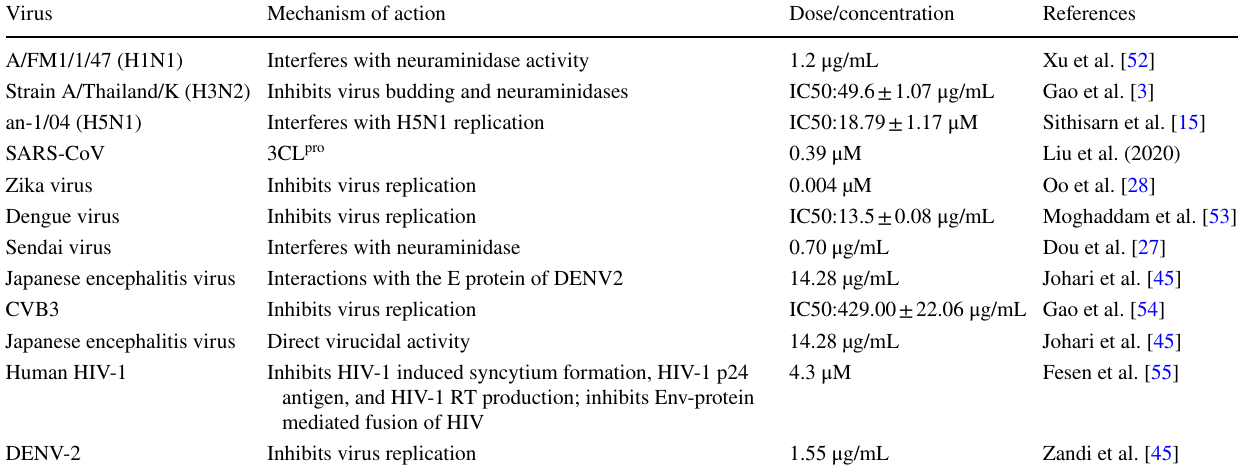
Table 3 Anti-virus activity of baicalin